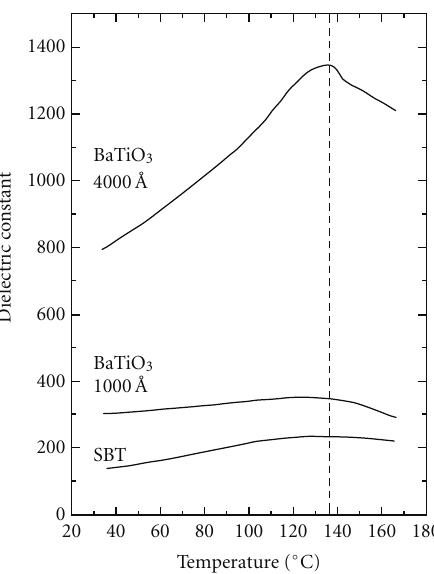
Figure 2: Temperature dependence of dielectric constant of SBT and BaTiO 3 epitaxial thin films on SrTiO 3 with 4000 ˚A and 1000 ˚A